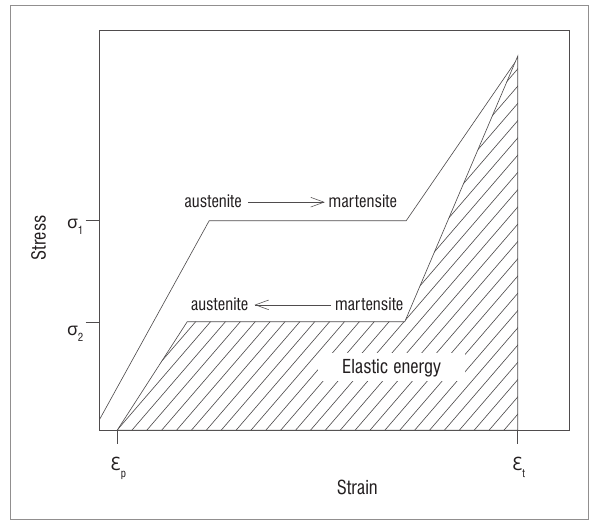
Figure 6: Stress versus strain characteristics showing